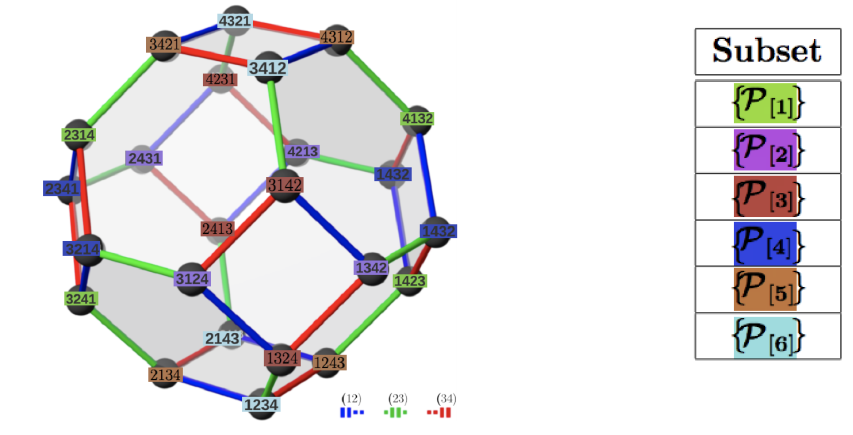
Figure 1 . Colored permutation addresses adorning the